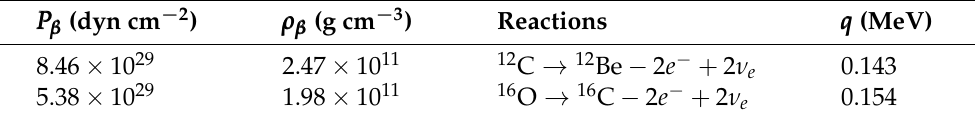
Table 4. Same as in Table 3, but for B (cid:63) =